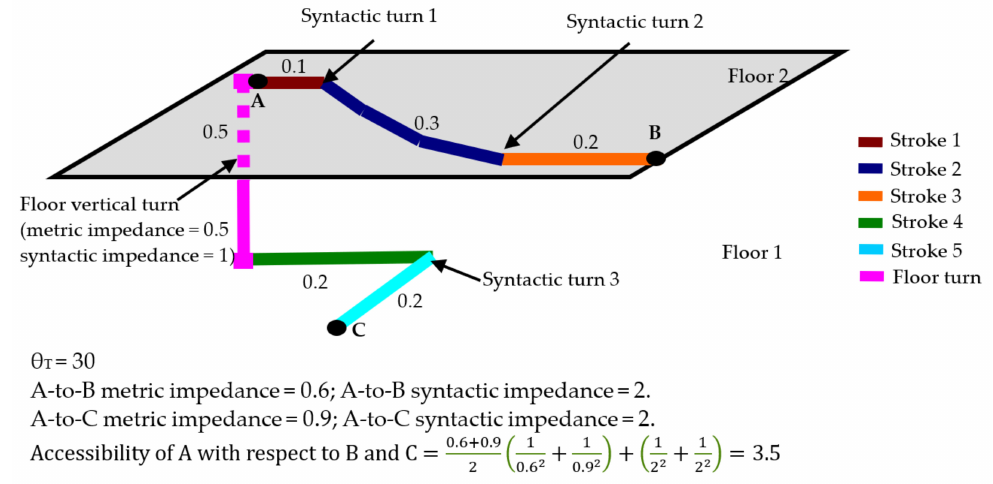
Figure 12. The metric-syntactic impedances of traveling paths and accessibility estimation with α = 2.